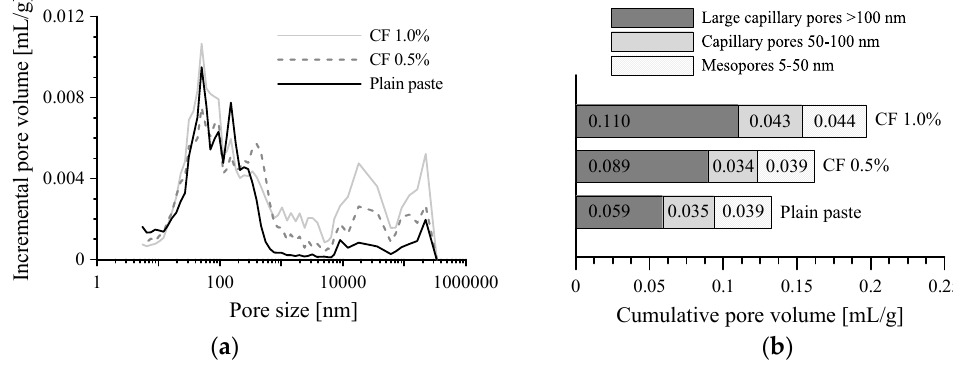
Figure 6. Porosity of cement-based composites with 0.5 and 1.0 vol.% CFs; ( a ) incremental pore volume; and ( b ) cumulative pore volume according to pore size. Sensors 2017 , 17 , 2516